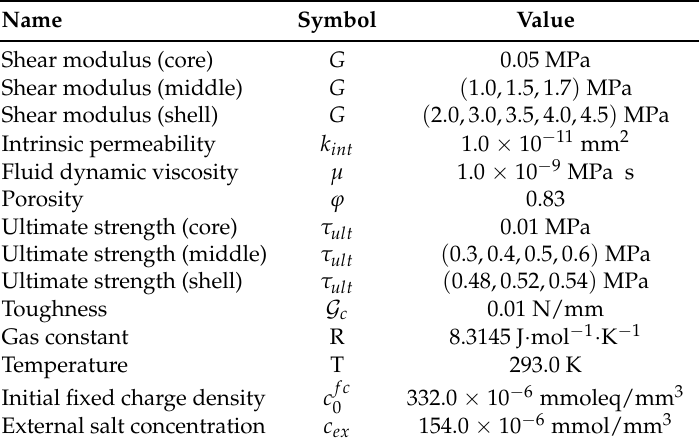
Figure 1. The geometry and boundary conditions of the sample. A changing chemical potential is applied along the outer surface. The red dashed line indicates the initial crack. ( R Shell = 0.5 mm, R Inner = 0.45 mm, R Core = 0.2 mm) Table 1. Material